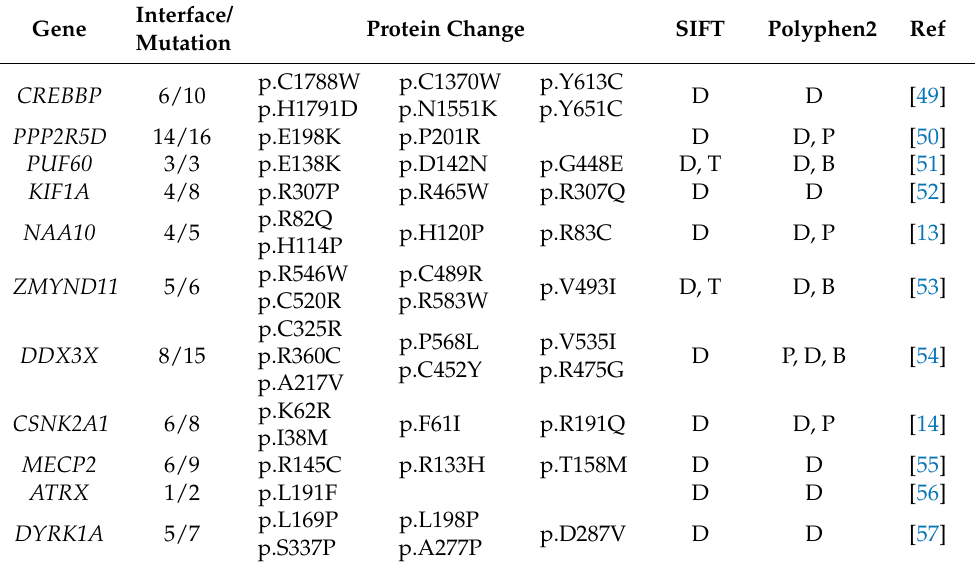
Table 1. List of all DD candidate genes identified by